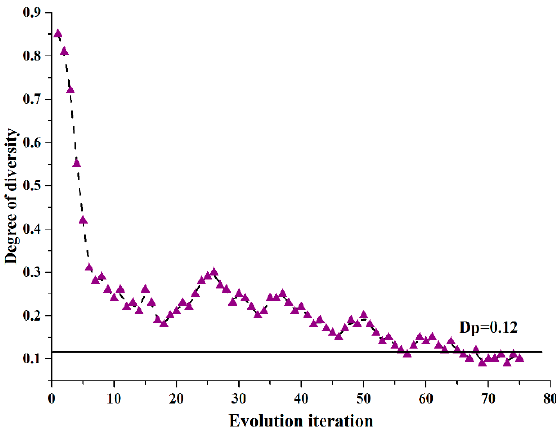
Figure 3. Convergence condition for proposed GA.